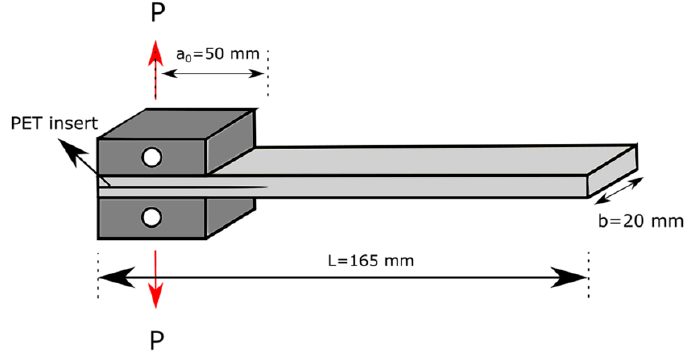
Figure 1. Dual cantilever beam (DCB) specimen for Mode I fracture toughness test.